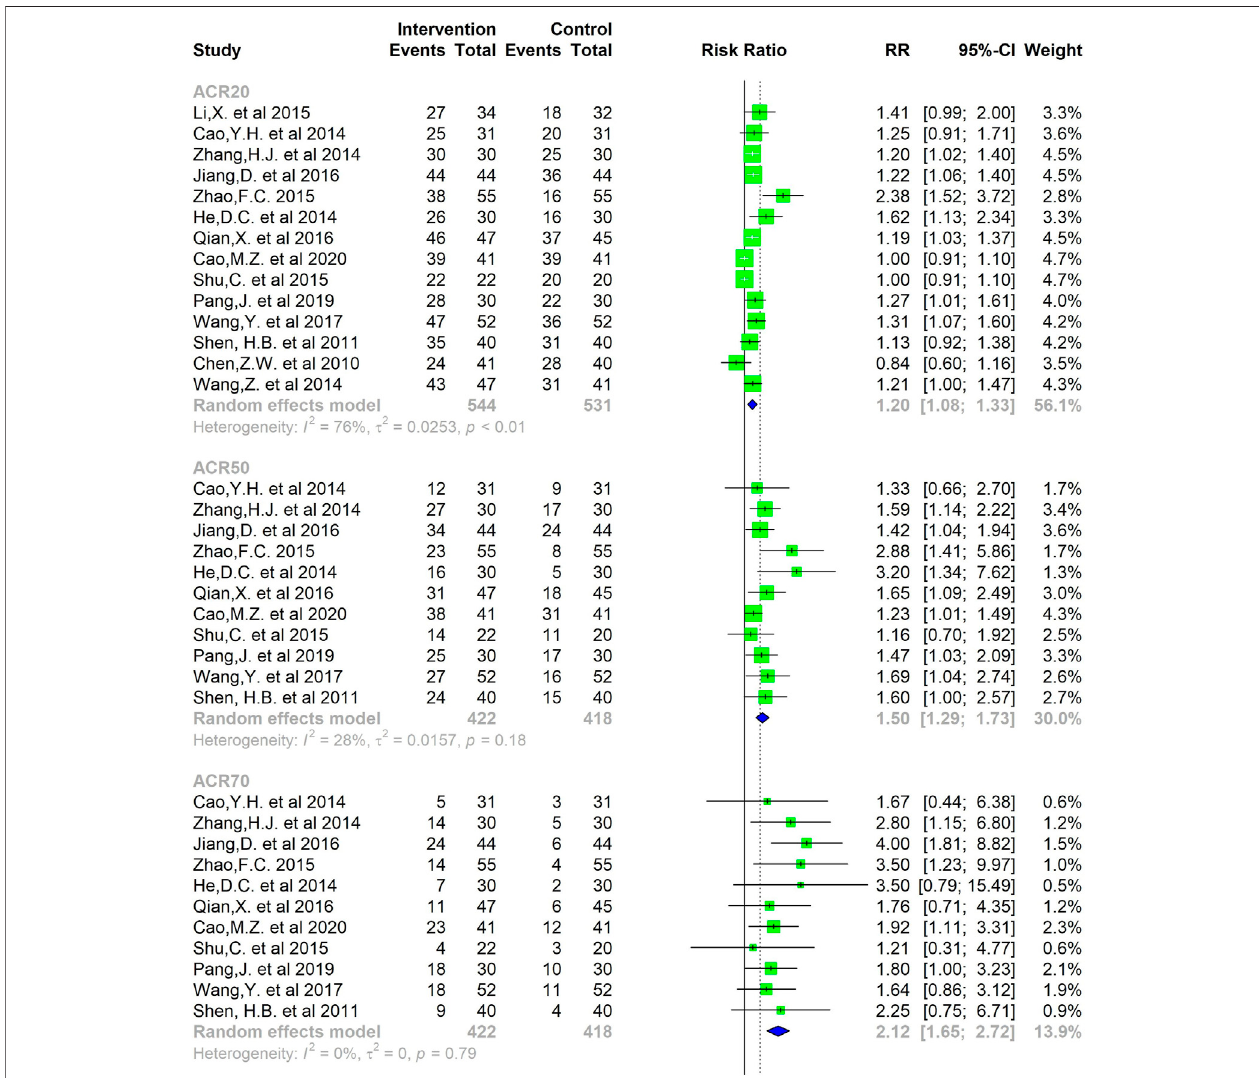
FIGURE 6 | Forest plot and meta-analysis of clinical ef fi cacy of TCM syndromes.